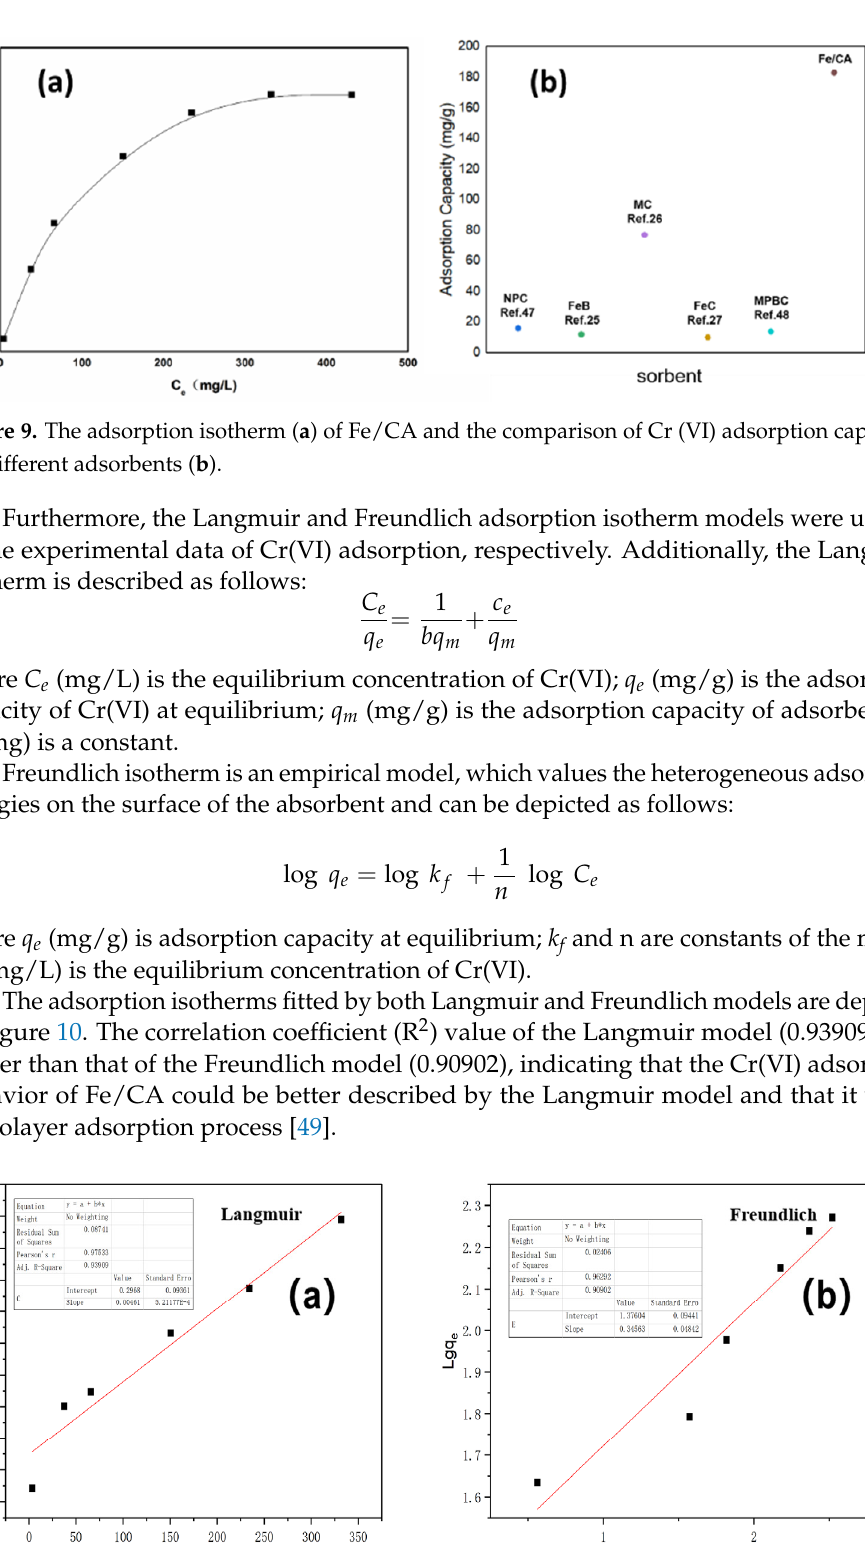
Figure 10. The Cr(VI) adsorption isotherm fitted by ( a ) Langmuir and ( b ) Freundlich models.